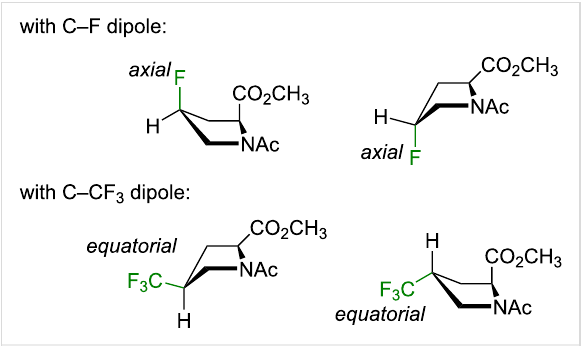
Figure 5: Preferred side-chain conformations according to the multi- plicity data.